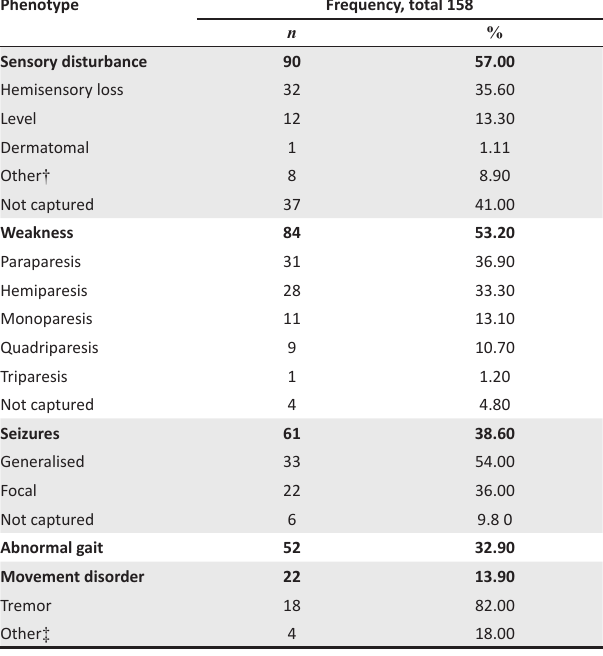
TABLE 2: Neurological presentations of functional neurological disorders.